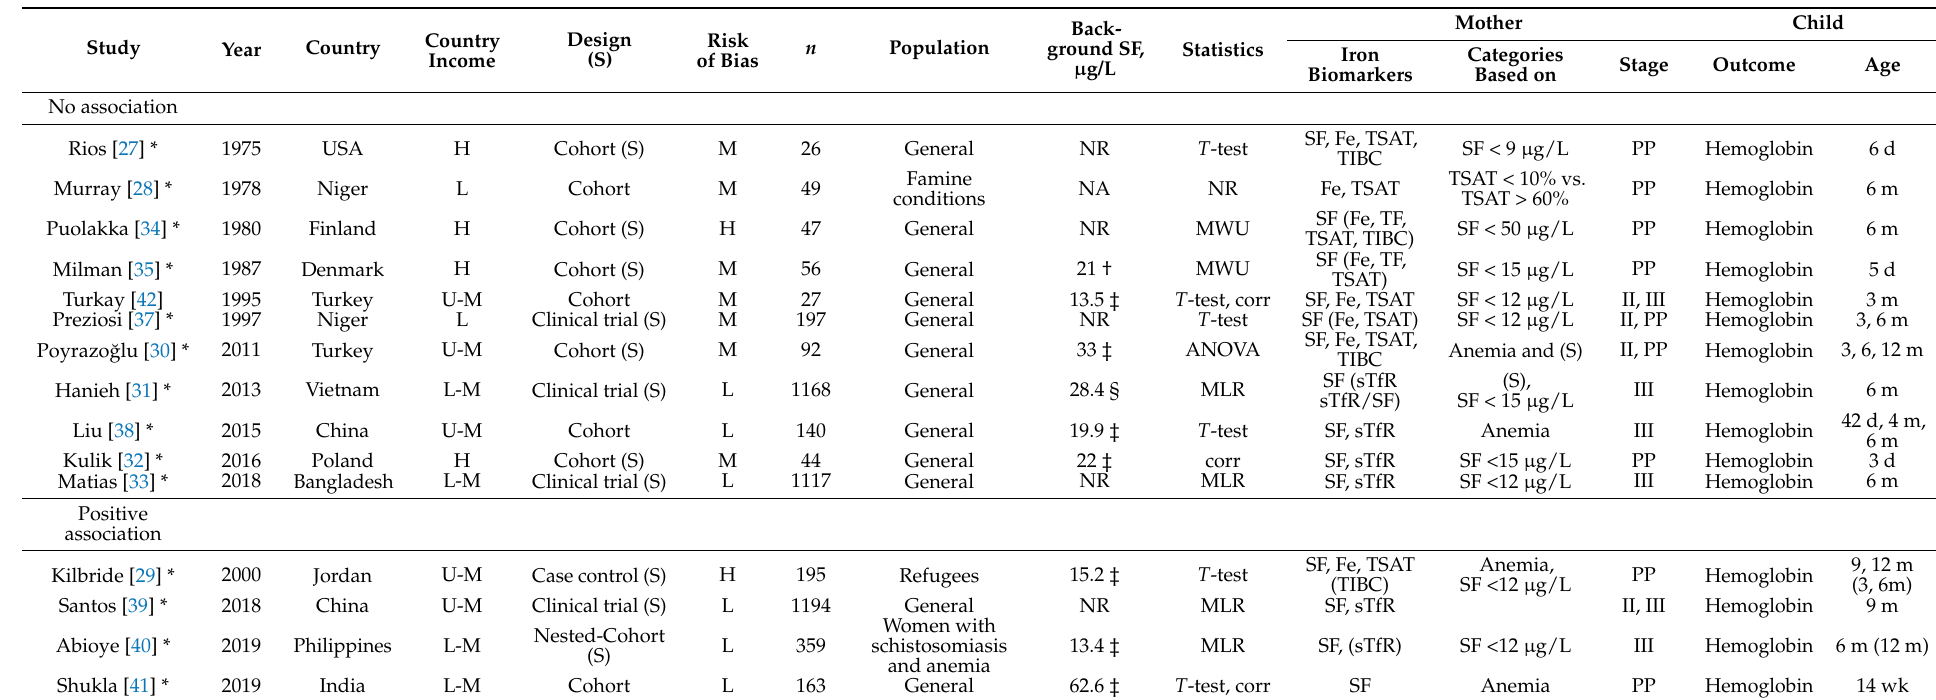
Table 2. Studies on maternal iron status and child hemoglobin concentrations after